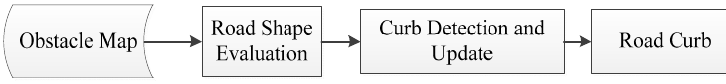
Algorithm 1. Distance Map Generation Process